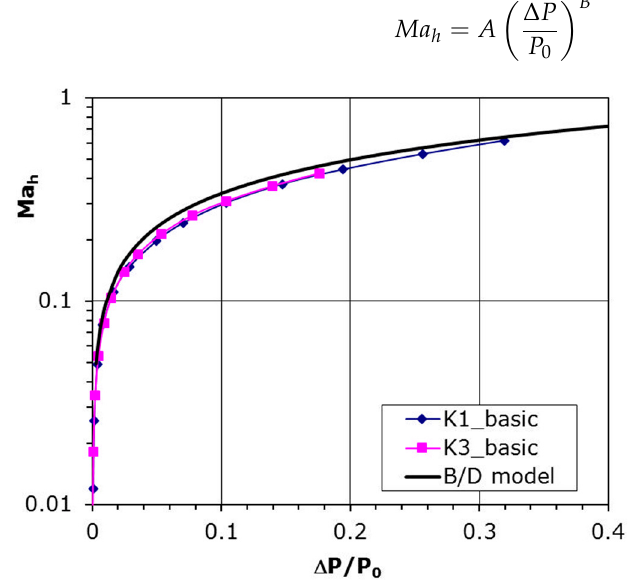
Figure 7. Comparison with other experiment for perforated plates in parallel flow, B/D model. Table 2. Coefficients for the Equation (7) formula, Mach number dependence from pressure